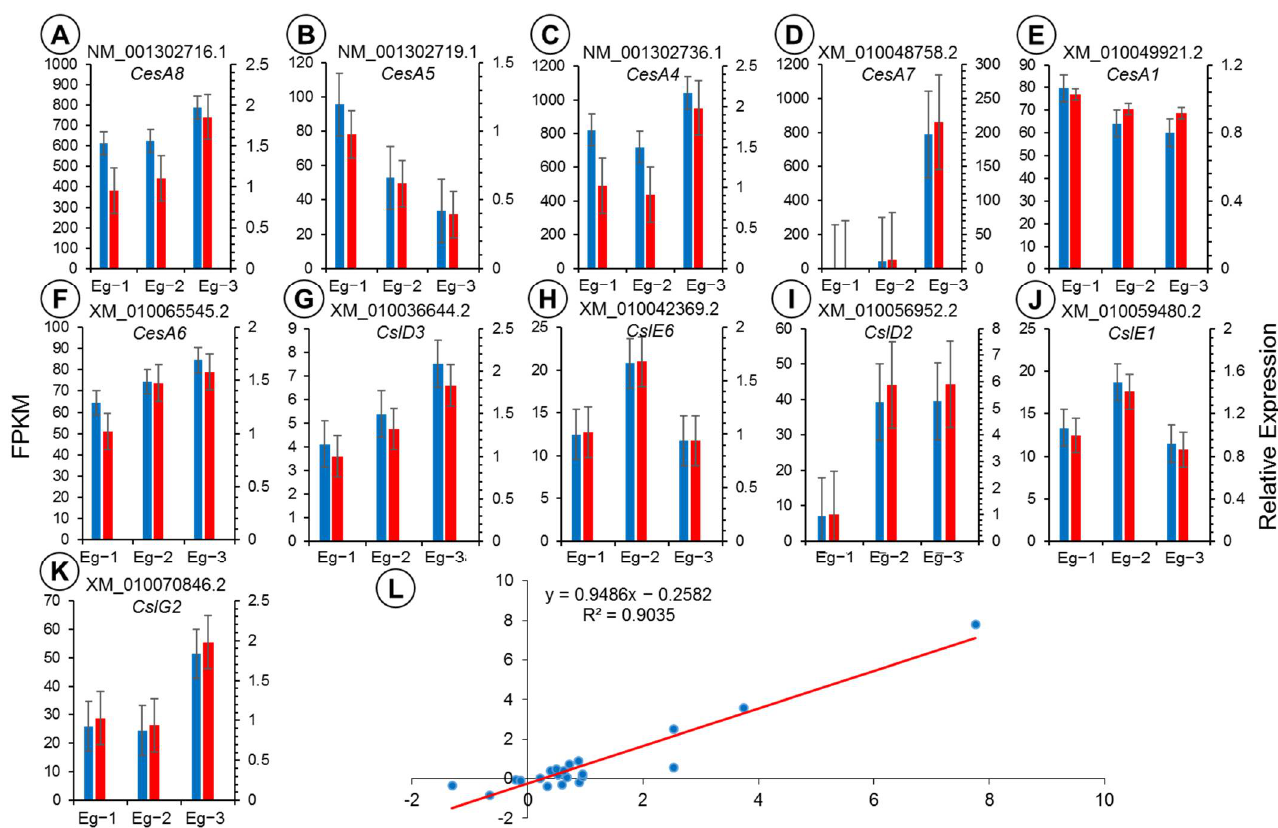
Figure 8. ( A – K ) Expression confirmation of the 11 genes using quantitative real-time PCR (qRT-PCR). ( L ) The correlation between qRT-PCR and the transcriptome data, as shown by values of log 2 (relative expression ratios) in qRT-PCR ( x -axis), plotted against the values of log 2 (RPKM ratios) in transcriptome data ( y -axis) for the 11 candidate CS genes. Red bars represent relative expression of target genes through qRT-PCR and blue bars represent FPKM values of 11 genes. Each sample was analyzed in three biological replicates.